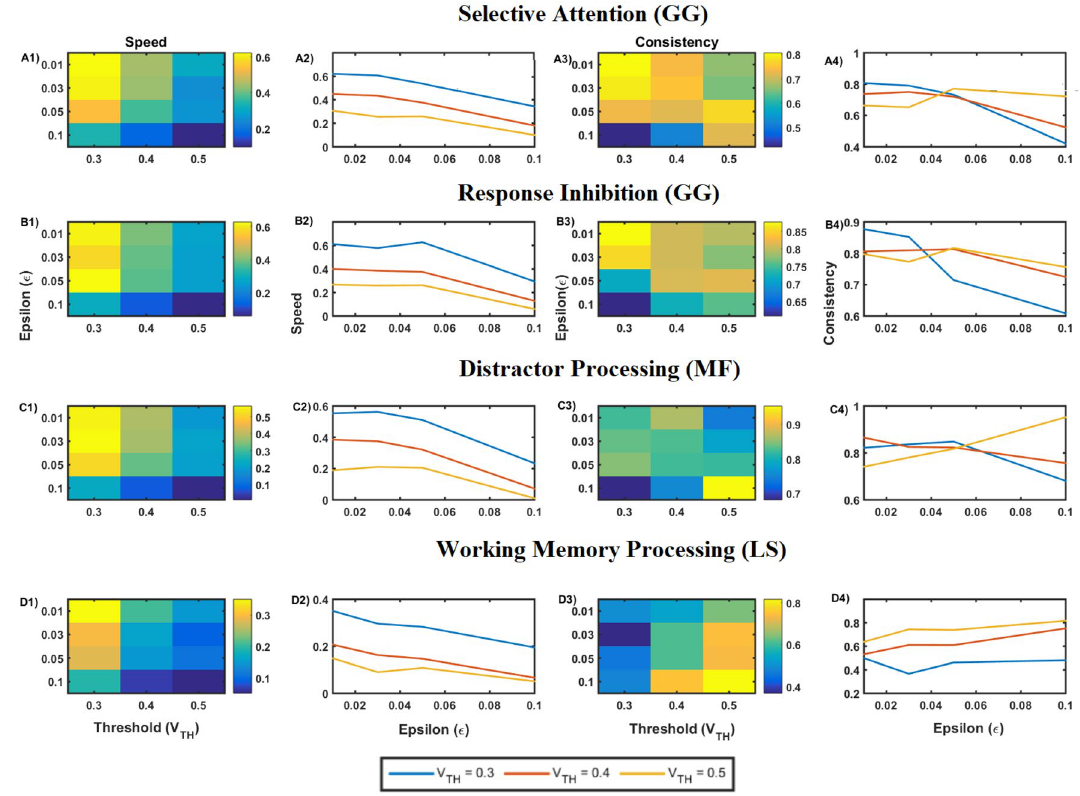
Figure 3. Plot of performance parameters for various tasks, with threshold ( varying between 0.3 to 0.5 and lateral connection strength ǫ ranging between 0.01 to 0.1. ( A1 , A2 ) The speed with which the decision is made for Go-Green (SA) task, ( A3 , A4 ) Consistency for Go-Green (SA) task, which indicates how consistent the performance was with respect to speed across trials. It also indirectly indicates the standard deviation of the speed of performance. Similarly, ( B1 – B4 ) represents the Go-Green (Response Inhibition) task, ( C1 – C4 ) indicates the Middle Fish (Distractor Processing) task, ( D1 – D4 ) indicate performance on the Lost Star task.